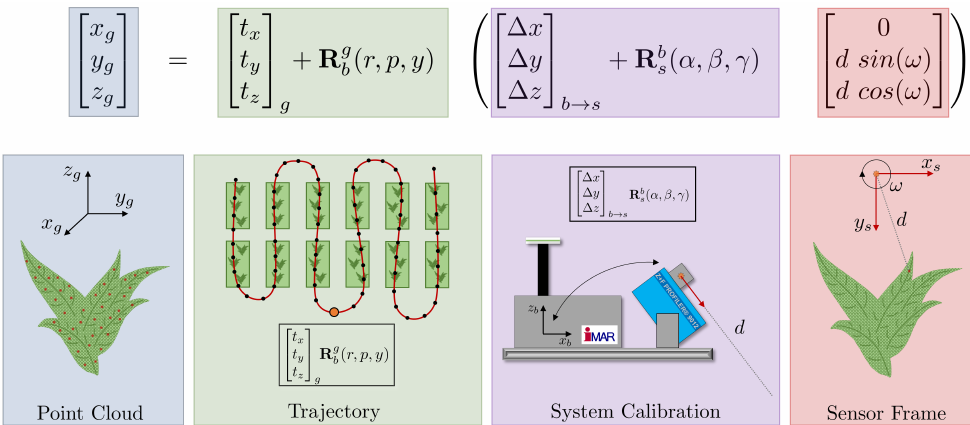
Figure 2. Schematic visualization of the direct georeferencing equation for the point cloud creation. Each laser measurement in the sensor frame on the right side is transformed into the global coordinate system on the left side by using the system calibration parameters and the system’s trajectory states of position and